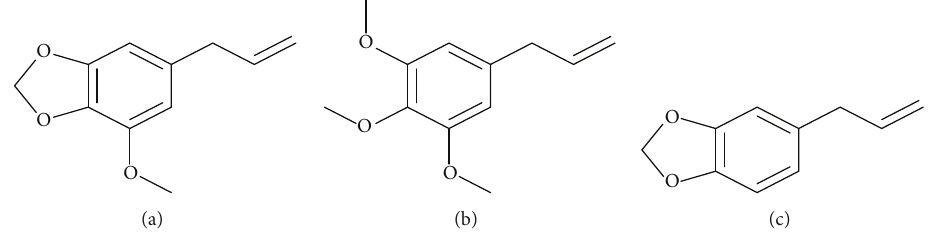
Figure 13: Structures of the main molecules of